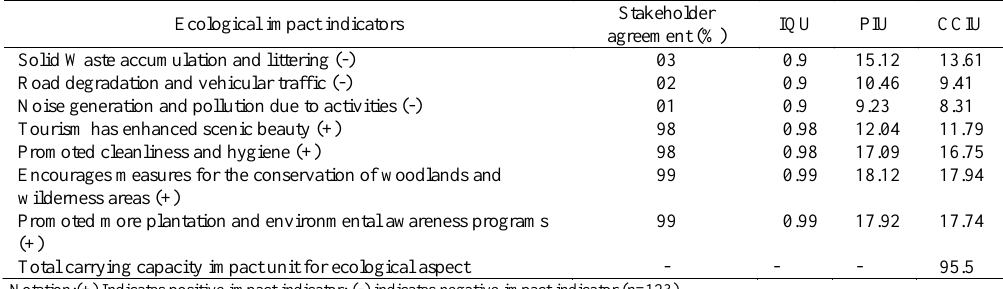
Table 4: Indicator quality unit and carrying capacity impact unit of ecological carrying capacity component Ecological impact indicators